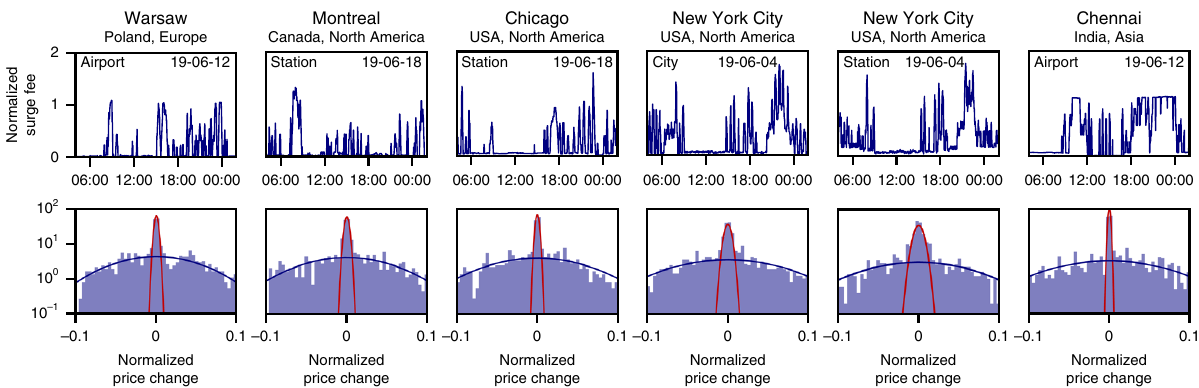
Fig. 4 Identifying non-equilibrium surge dynamics and anomalous supply shortages. Repeated price surges similar to those observed at DCA (compare Fig. 3e) emerge in locations across the globe (America, Asia, and Europe) and independent of type of origin (airport, train station, and other prominent locations). The surge dynamics at the six locations identi fi ed in Fig. 3a is qualitatively and statistically similar to DCA. In particular, sustained periods